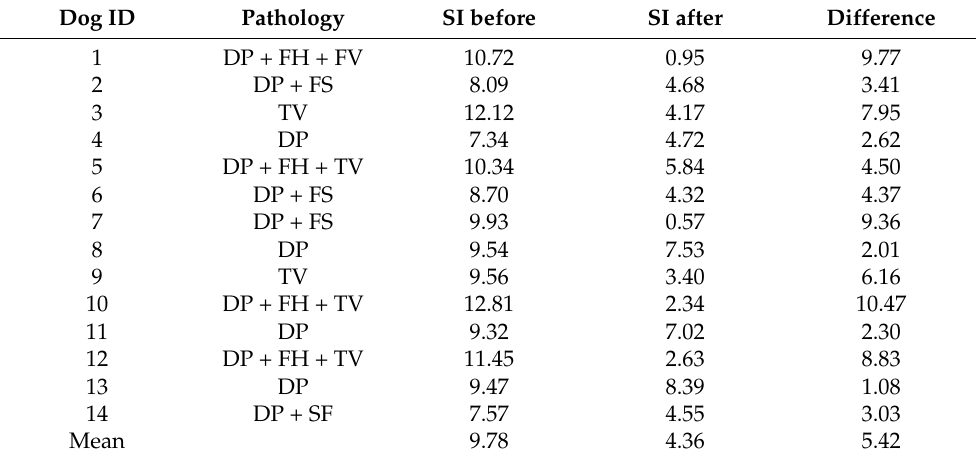
Table 3. This table includes the pathology, the SI (symmetry index) of each dog before and after the treatment, as well as the difference between them. The last row shows the mean values of the group. Dog ID Pathology SI before SI after